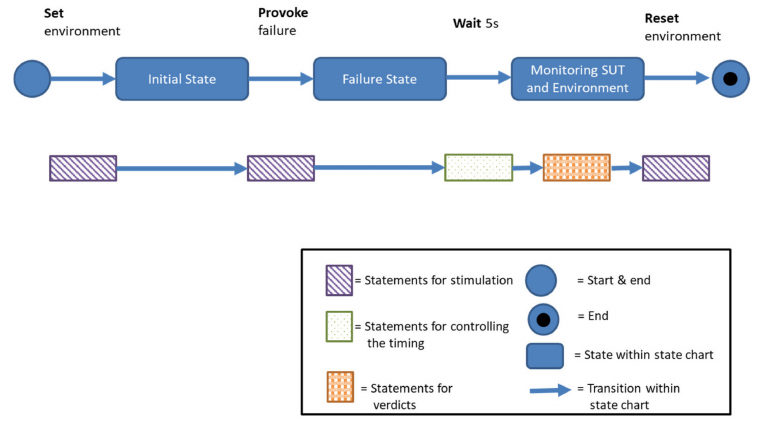
Figure 2. Mapping of test case steps to statement types.